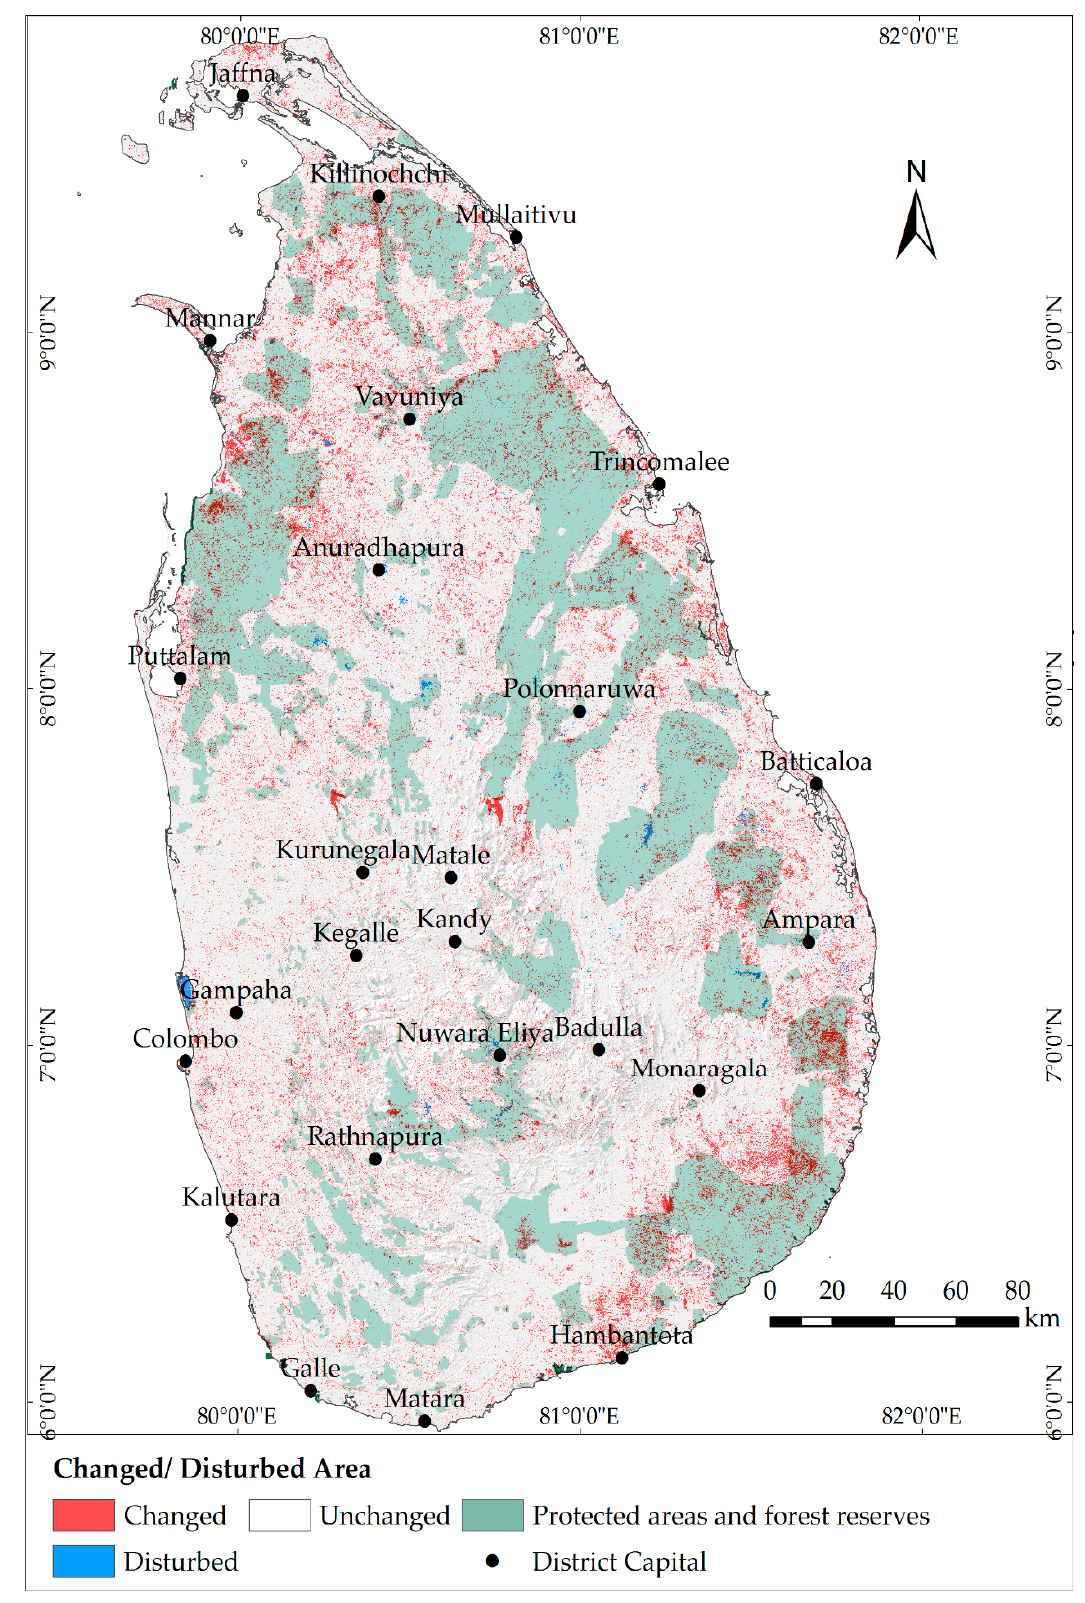
Figure 6. Areas that experienced a disturbance and / or land use land cover change (LULCC) over the 1993 to 2018 period and the distribution of protected areas and forest reserves across Sri Lanka [55] .